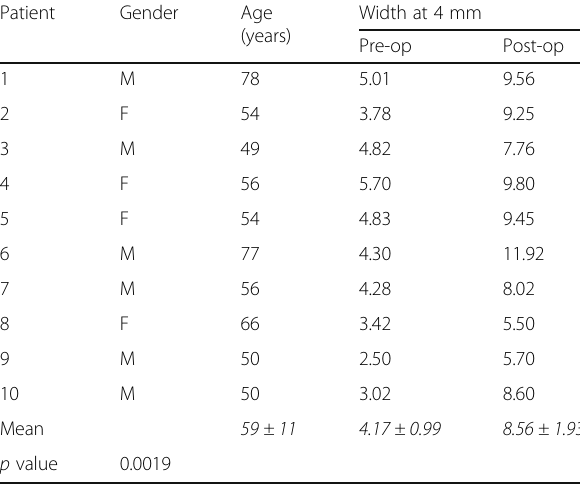
Table 1 Ridge width gain at 4 mm from the crest of the